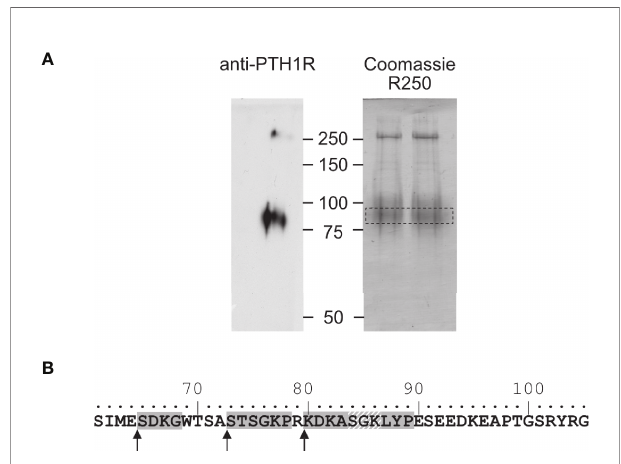
FIGURE 3 | Mapping of the protease cleavage site of PTH1R ECD by N- terminal sequencing. (A) Human PTH1R with C-terminal Strep-Tag II was puri fi ed from stably expressing CHO cells by two-step af fi nity puri fi cation. A fraction of the puri fi ed receptor was subjected to Western blot and probed with anti-PTH1R antibodies (left panel). The remaining puri fi ed receptor protein (~50 µg) was transferred on PVDF membranes and stained with Coomassie blue R250. The band corresponding to PTH1R was cut out and subjected to microsequencing (right panel, dashed box). (B) Sequence of exon E2 (amino acids 61-105). Sequences obtained from microsequencing are shaded gray. The position of the N-terminal amino acid is marked by an arrow. Residues 84-86 (gray diagonal stripes) were not resolved in the Edman degradation.